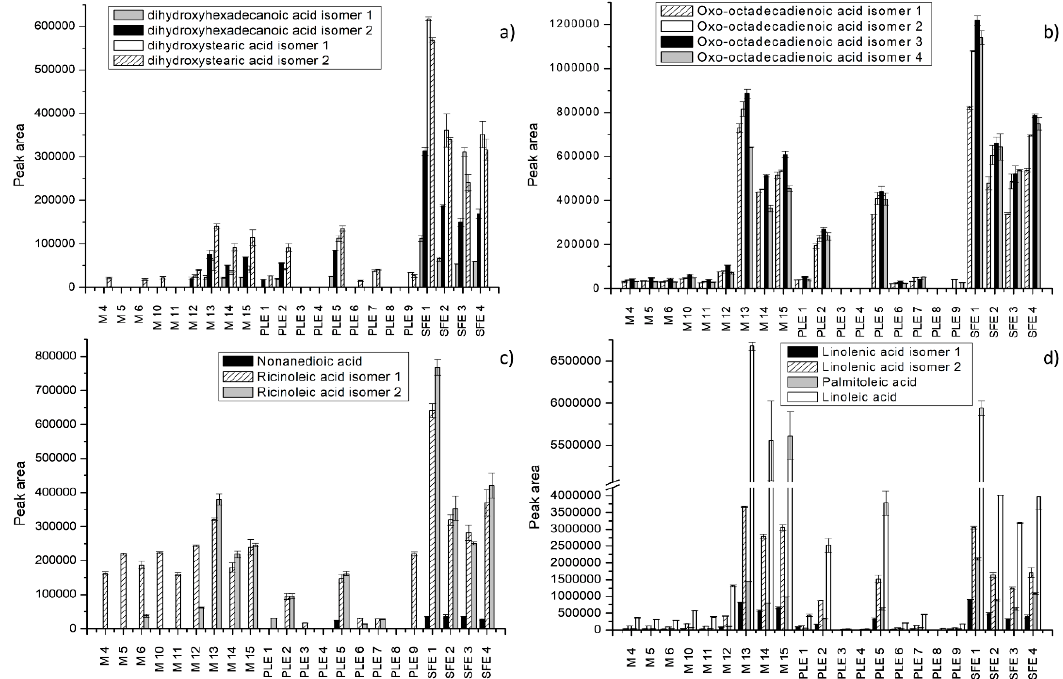
Figure 4. Extraction efficiency of different extraction techniques expressed as peak areas of some fatty acids and derivatives. ( a , b ) Dixydroxyhexadecenoic acid isomers, dixydroxystearic acid isomers and oxo-octadecadienoic acid isomers; ( c,d ) nonanedioic acid, ricinoleic acid isomers, linolenic acid isomers, palmitoleic, and linoleic acid.